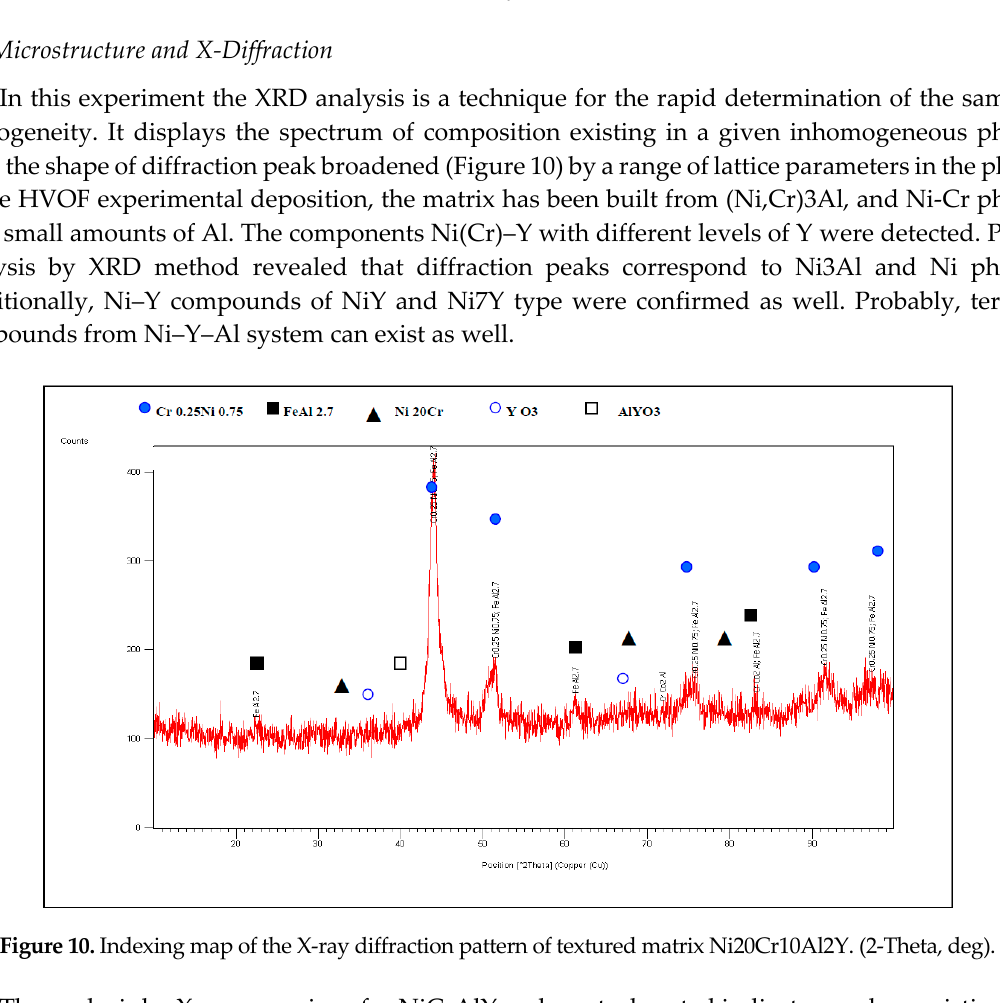
Figure 9. SEM image of Ni20Cr10Al2Y coatings showing HVOF surface deposition ( a ), relatively uniform and dense structure in the section of the layer ( b ).